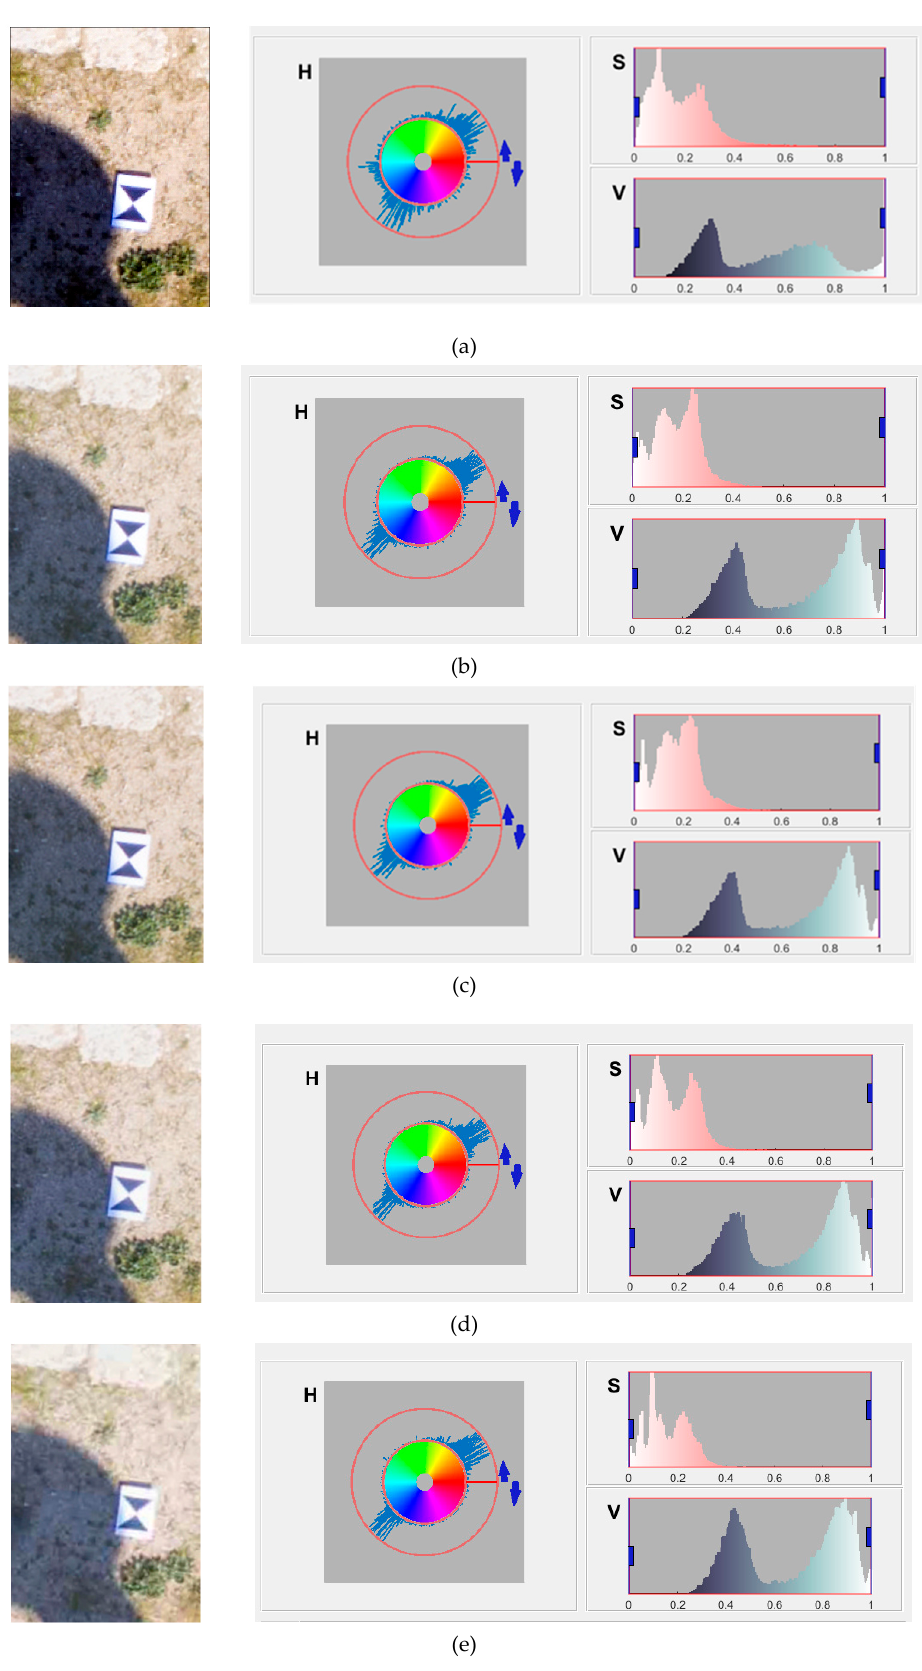
Figure 7. Particular of the several orthophoto and their color features: ( a ) DNG, ( b ) TIFF, ( c ) JPEG12 ( d ) JPEG6, ( e ) JPEG1.